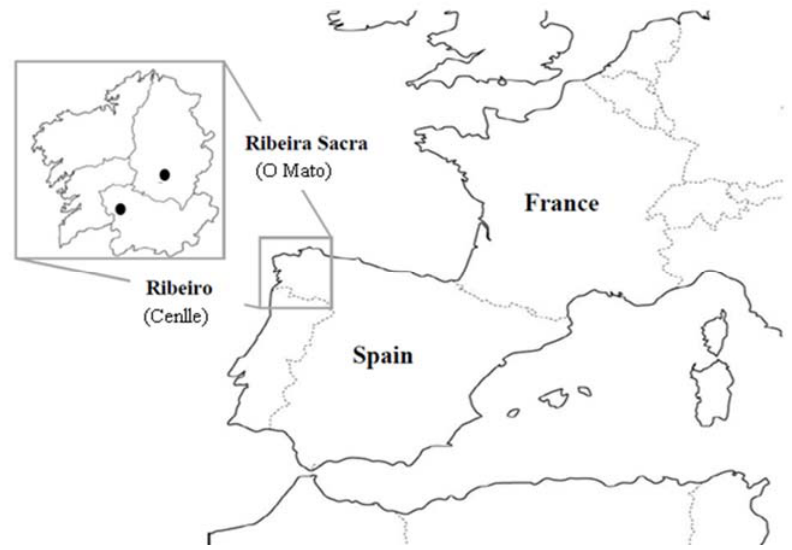
Figure 1. Location of the Ribeiro (Cenlle) and Ribeira Sacra (O Mato) Designation Origin areas in the Northwestern Spain.